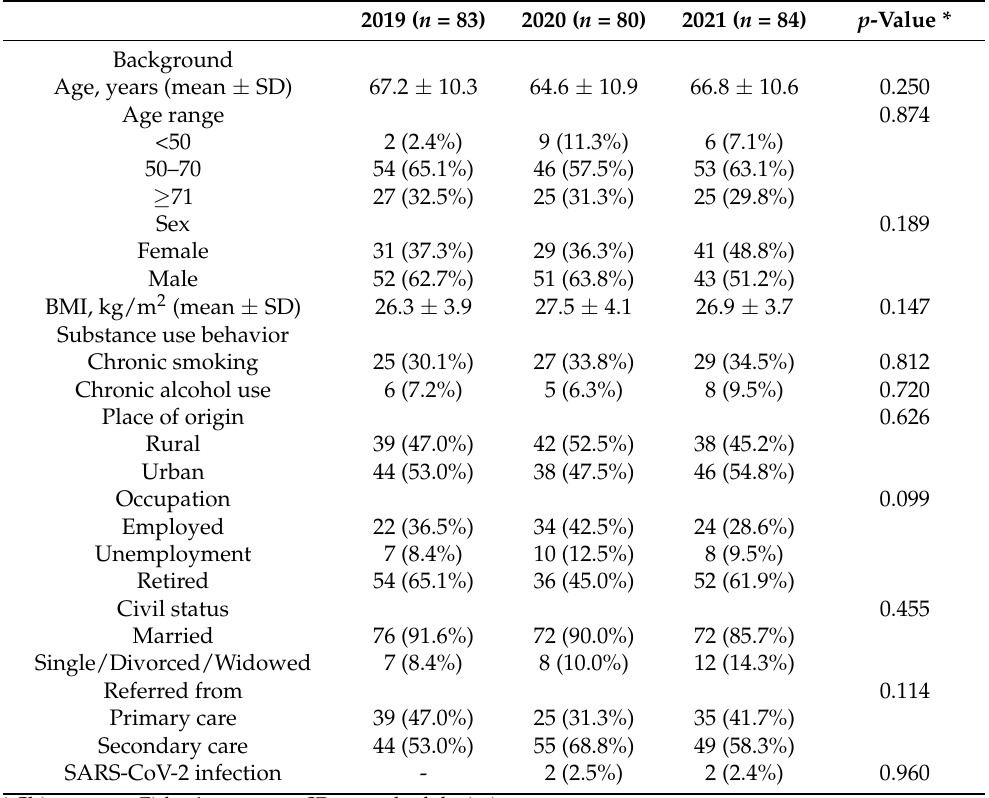
Table 1. Baseline characteristics of patients with colorectal cancer stratified by the year of initial surgical